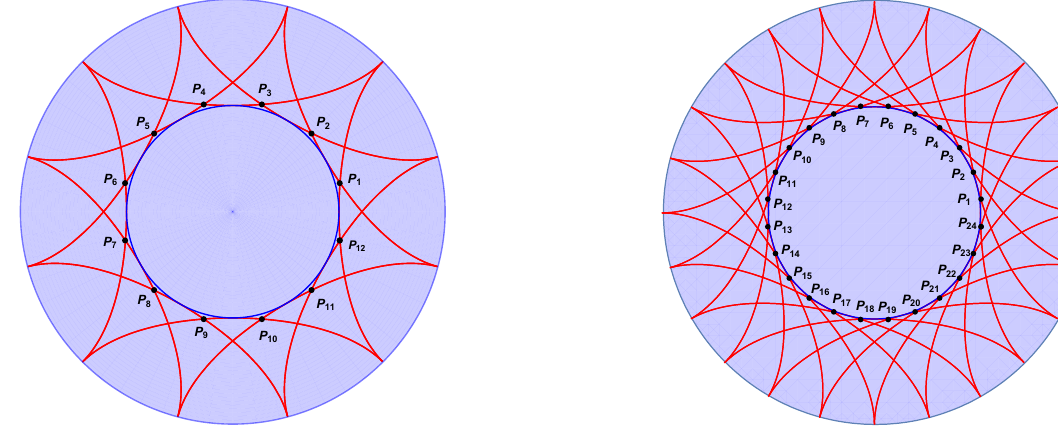
Figure 1 . Two sequences of geodesics tangent to a common bulk static curve. On the right, the sequence is (cid:12)ner and the intersection points of consecutive pairs of geodesics live closer to the bulk curve. In the continuum, the intersection points approach the bulk curve, which is identi(cid:12)ed with the common envelope of the